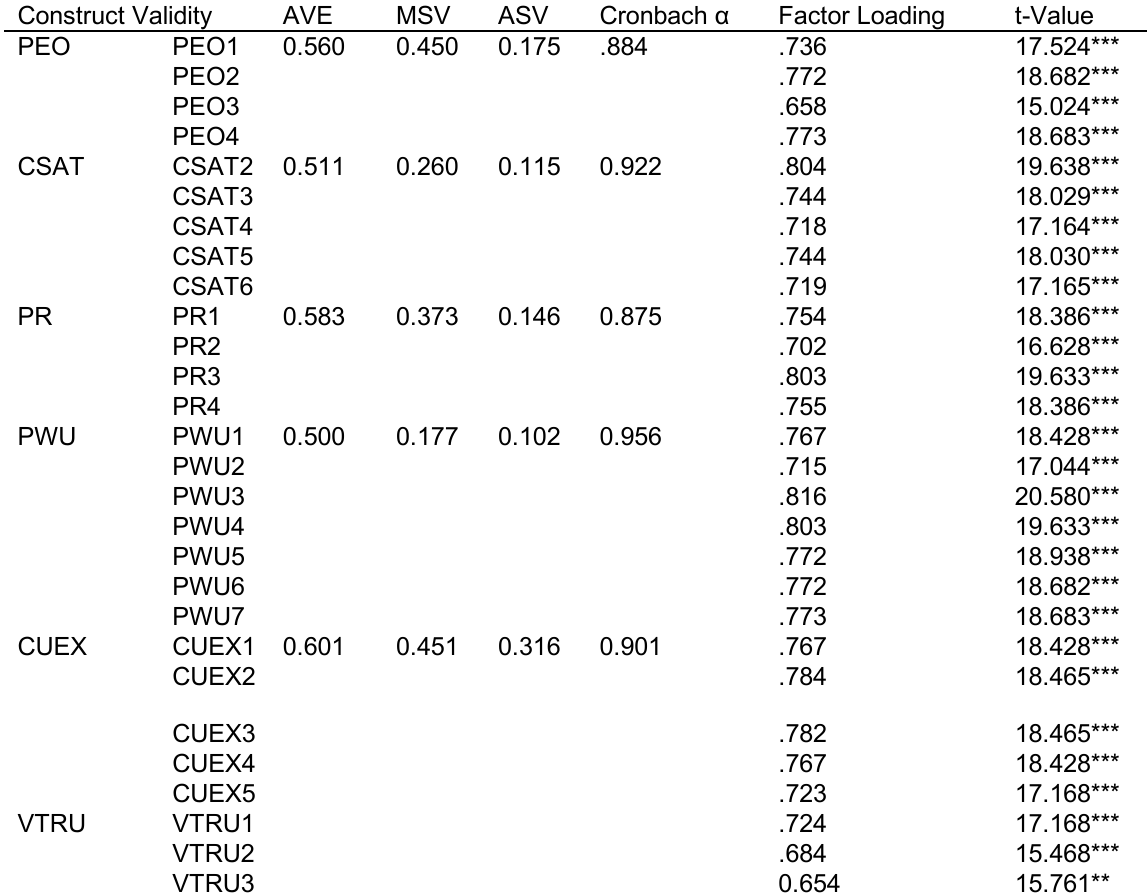
Table 4: Overall reliability of the constructs and factor CFA loadings of